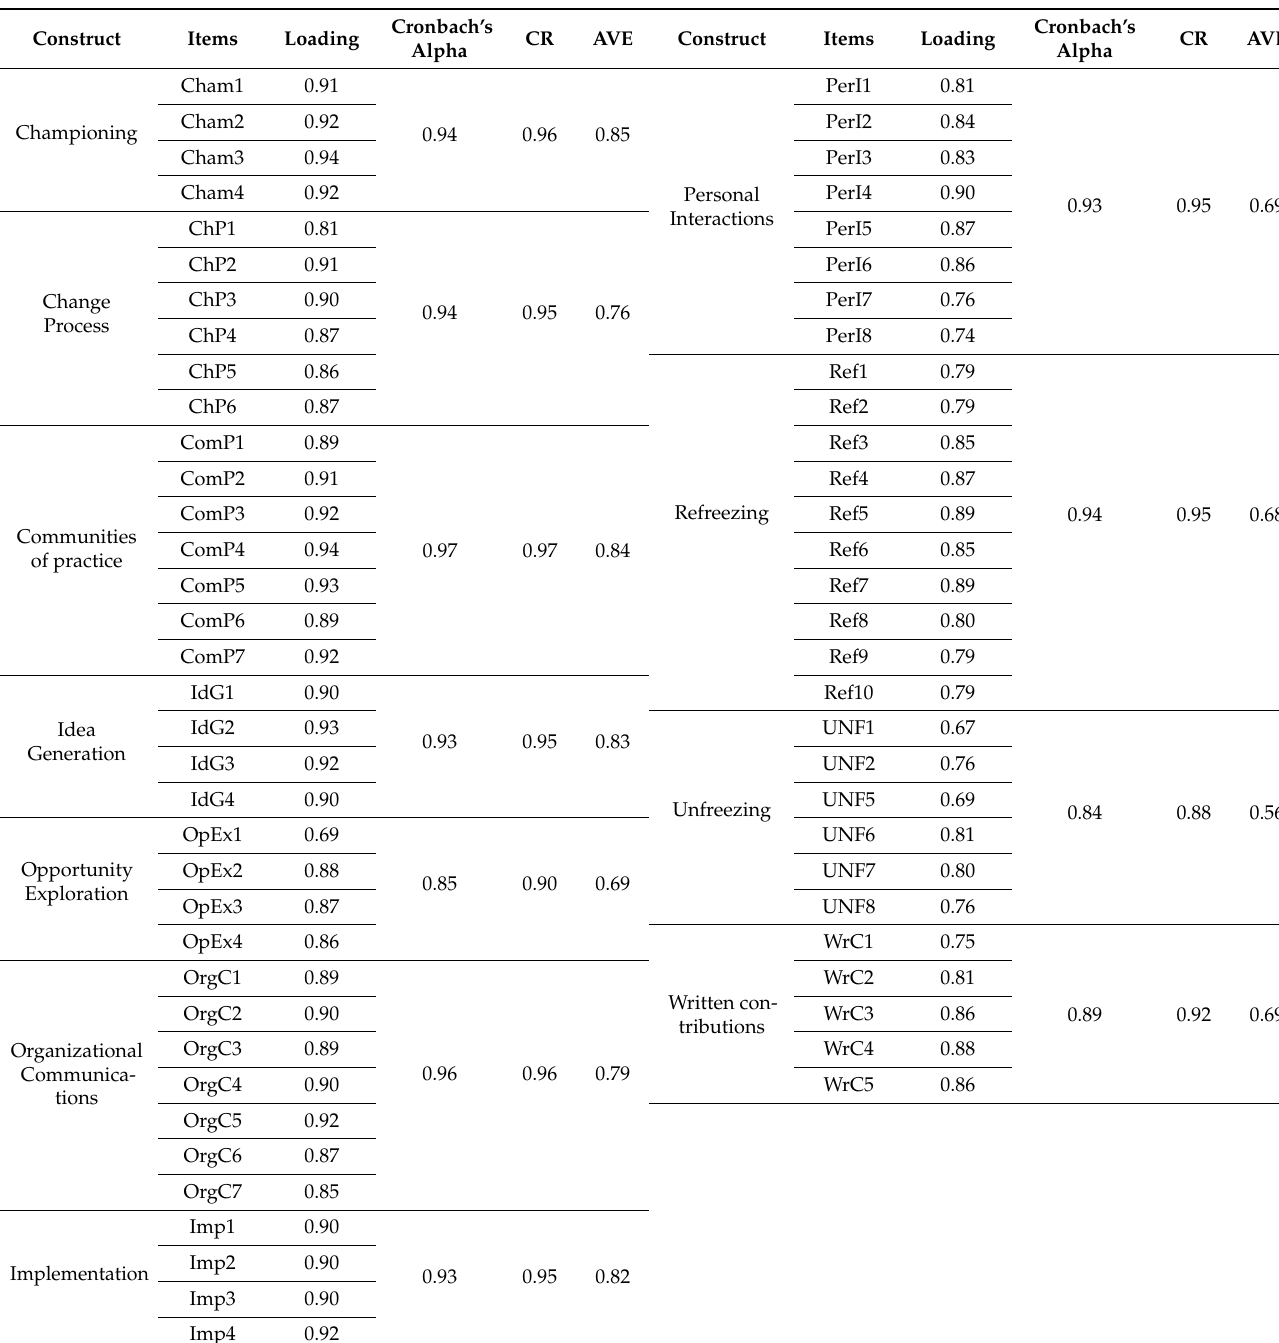
Table 2. Internal consistency, convergent validity, composite reliability, and